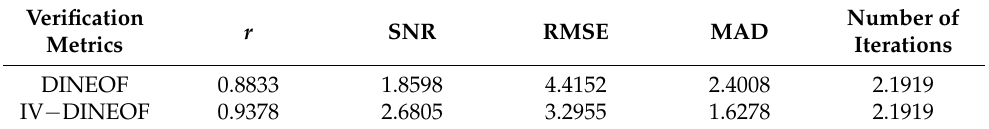
Table 3. Comparison of verification metrics between DINEOF and IV − DINEOF for Dataset2.